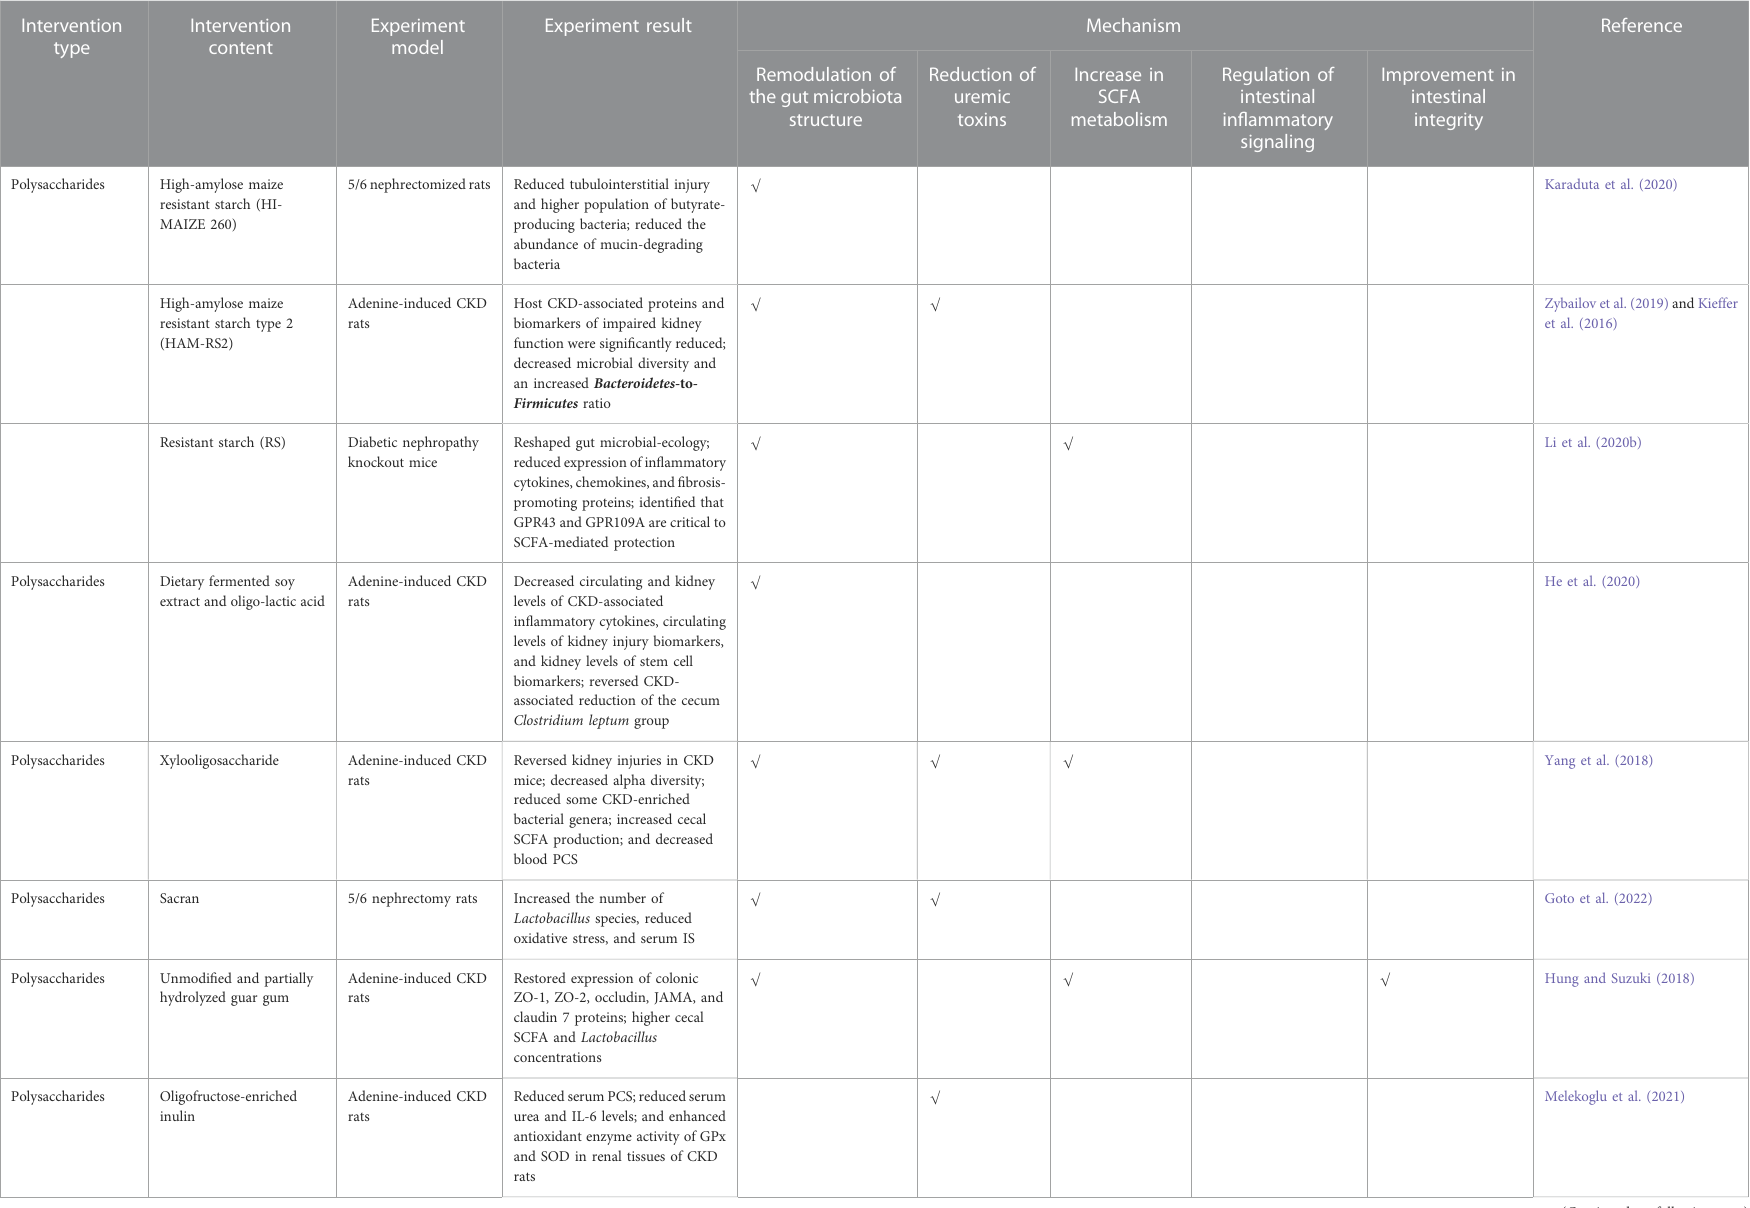
TABLE 1 ( Continued ) Mechanisms of gut microbiota as an alternative target for natural products from plants and microorganisms for the treatment of CKD in animal